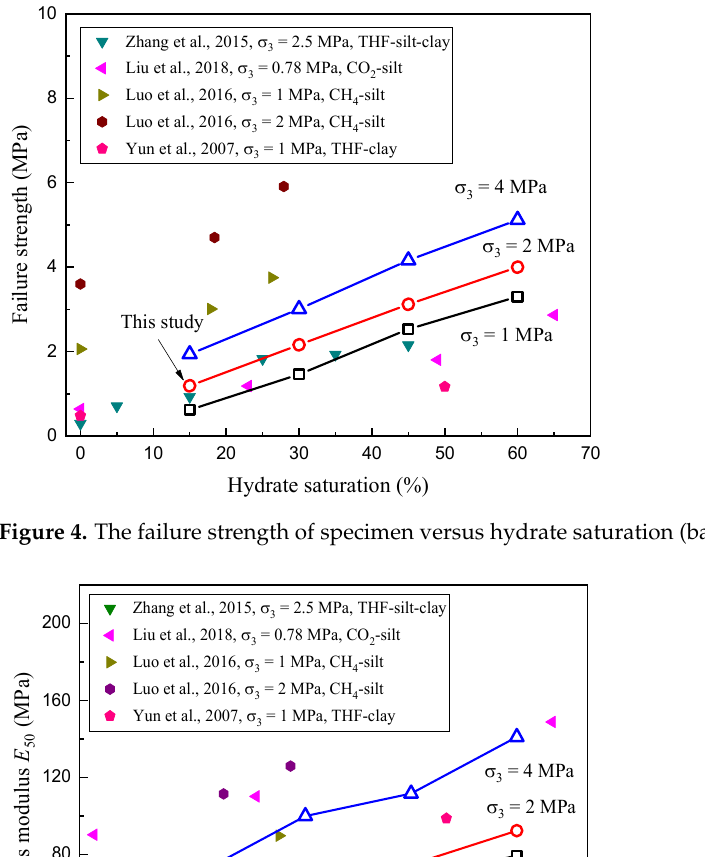
Figure 5. Variation of Young’s modulus E 50 with hydrate saturation (based on [21–23,27]).